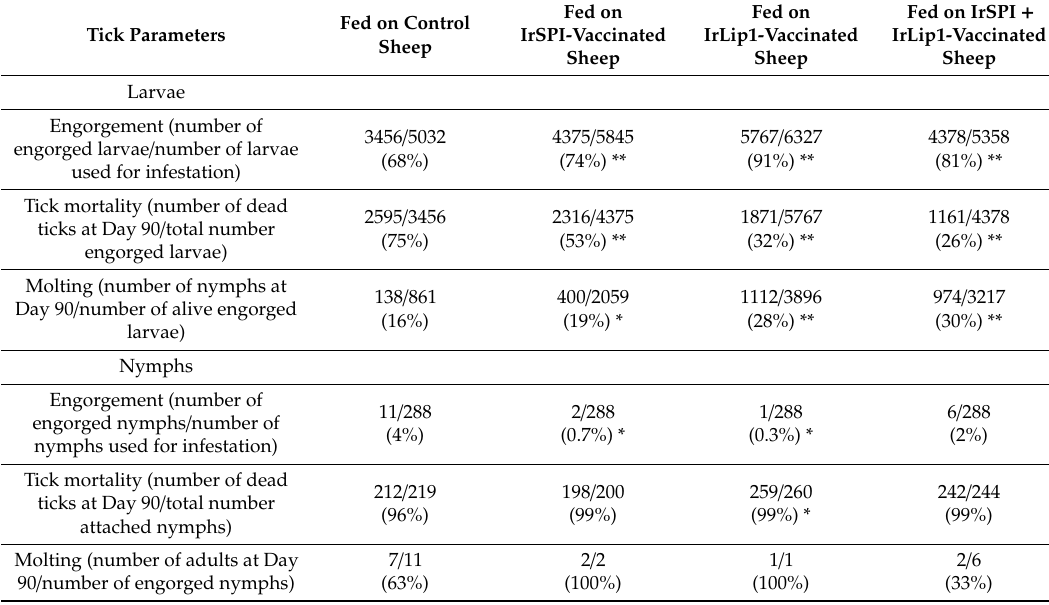
E ff ect of vaccination of sheep with recombinant IrSPI and IrLip1 proteins on tick infestation